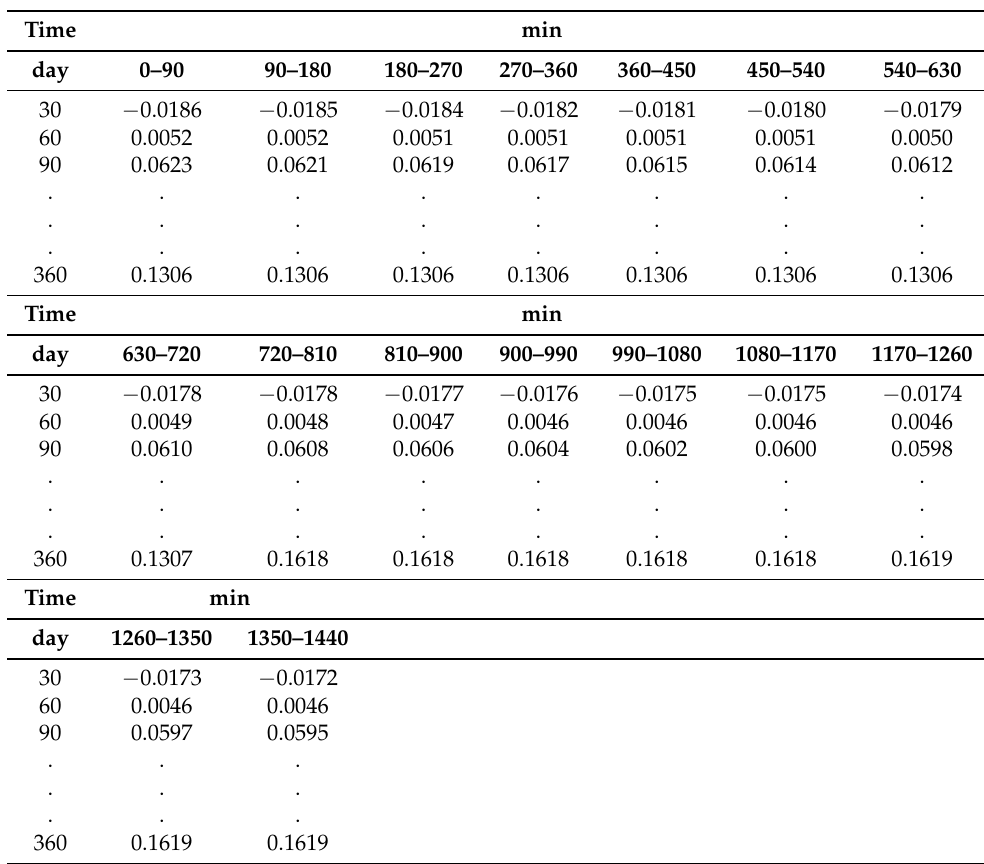
Table 4. The averaged wave crest impact in one year (360